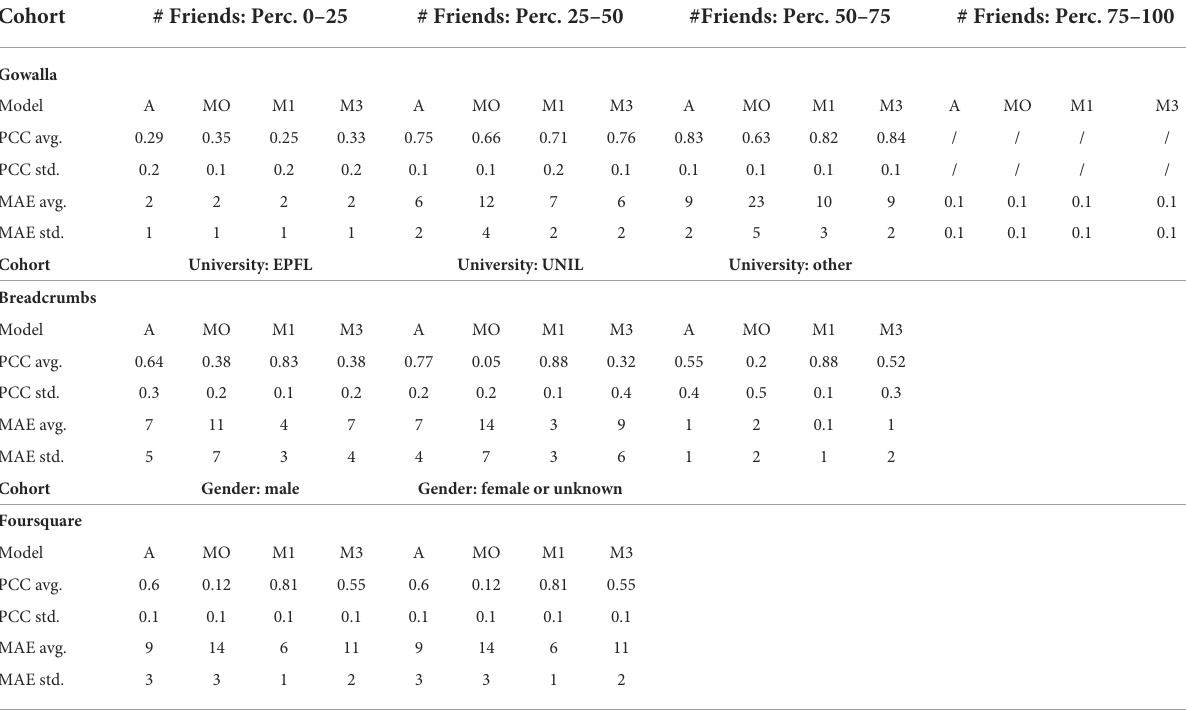
TABLE 2 Pearson’s Correlation Coefficient (PCC) and Mean Absolute Error (MAE) for predicting next-week’s average cohort ratios.